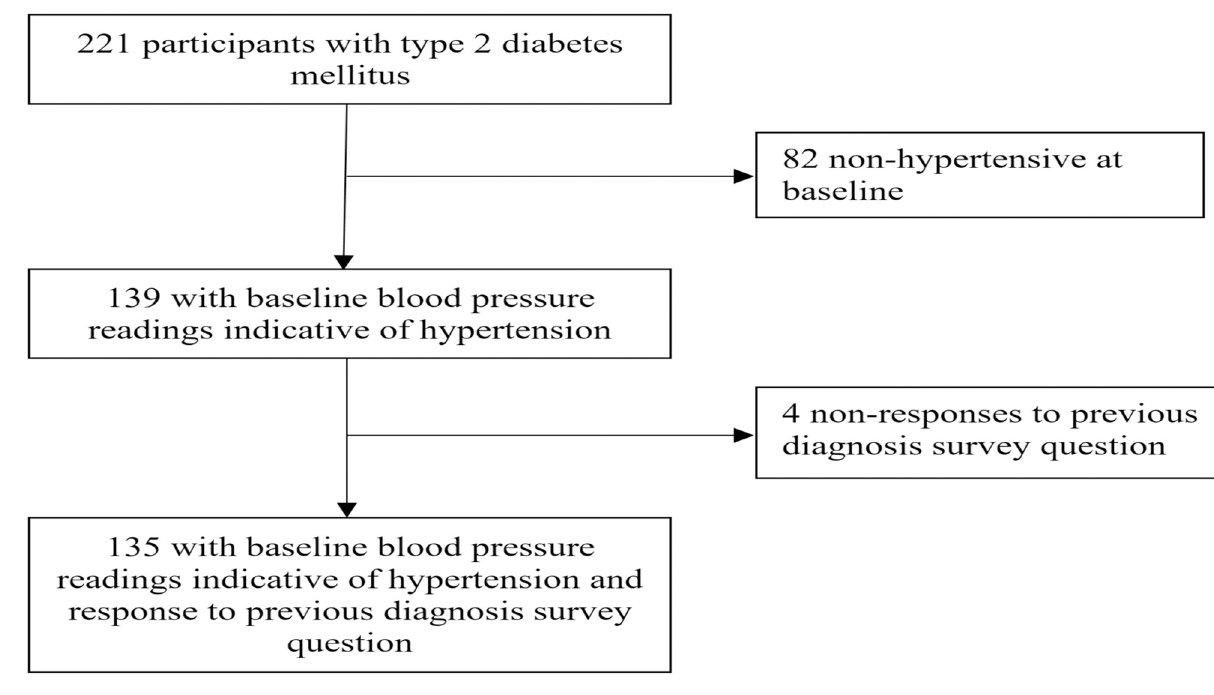
Fig 1. Participant sample flow diagram. https://doi.org/10.1371/journal.pone.0250489.g001 Table 1. Descriptive statistics of demographics and biometric measures among participants with blood pressure readings indicative of